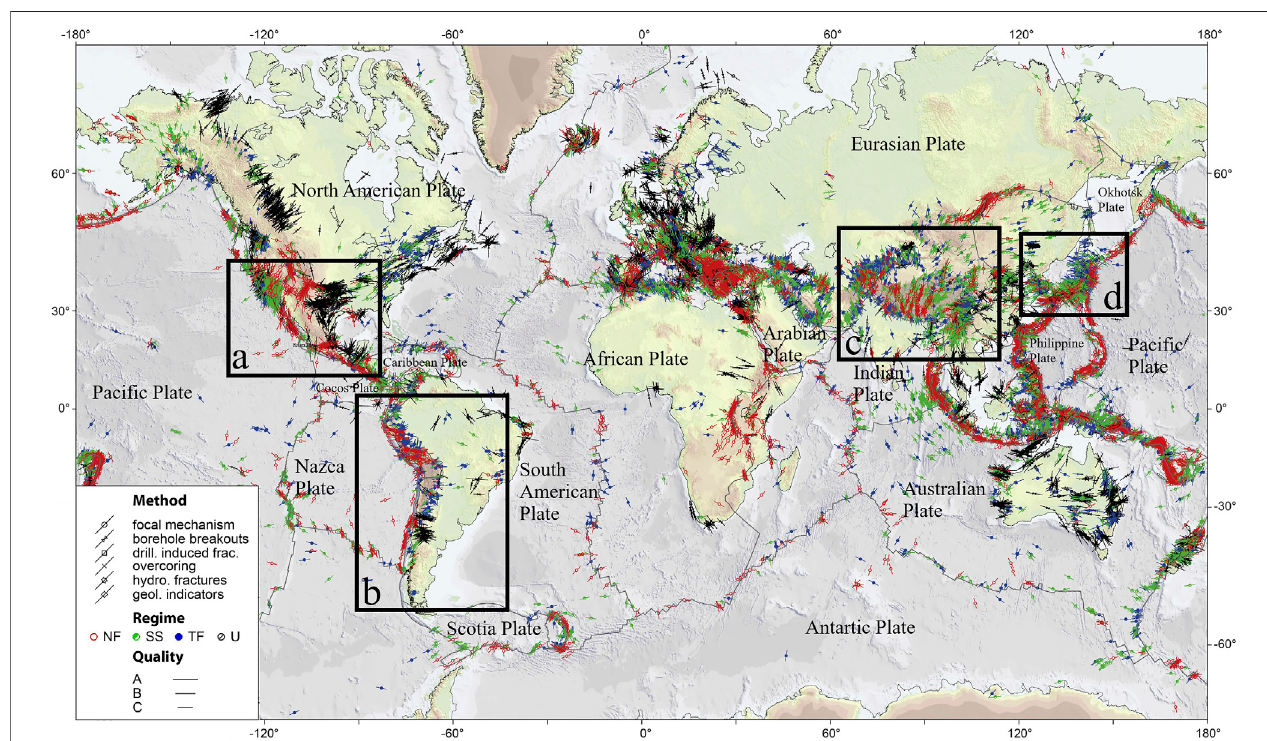
FIGURE 1 | World Stress Map from WSM 2016 database release. Lines show the orientation of maximum horizontal stress ( σ Hmax ) for the 40 km upper crust from differentstressindicatorsdisplayedbydifferentsymbols;linelengthisproportionaltodataquality (A – C) .Colorsindicatethestressregime:I)red=normalfaulting(NF),II) green = strike-slip faulting (SS), III) blue = thrust faulting (TF), and IV) black = unknown regime (U). Grey lines give plate boundaries from global model PB2002 of Bird (2003).Theseismiczonesanalyzedareshowninthemarkedrectangles: (A) UnitedStates-Mexico, (B) SouthAmerica, (C) SouthernChinaandNorthernIndia,and (D)